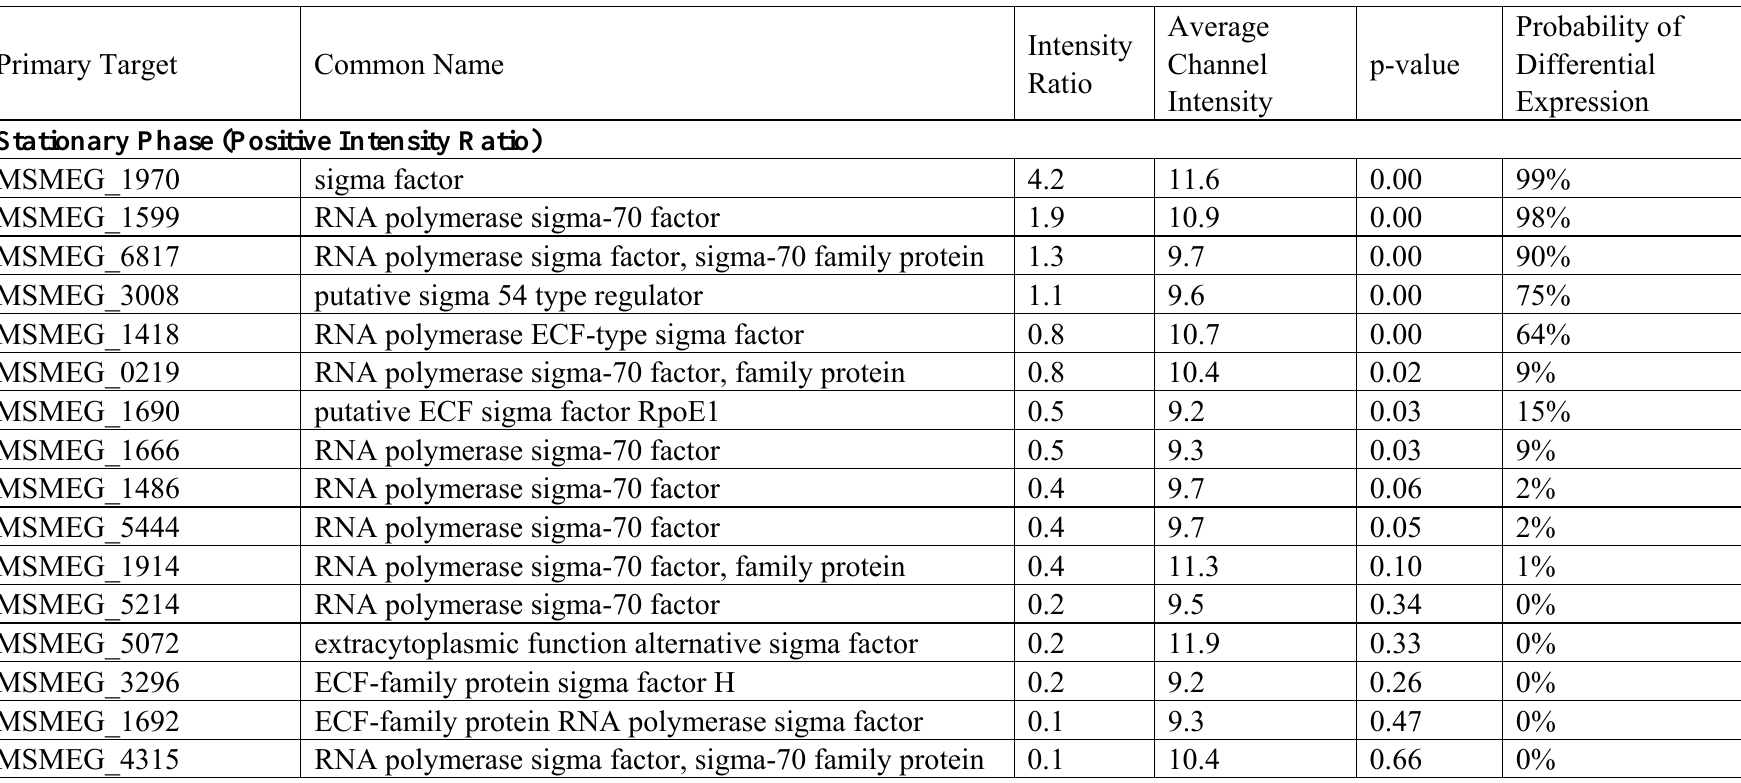
Appendix Table 4. Differential gene expression of sigma factors (non-spray dried log versus stationary